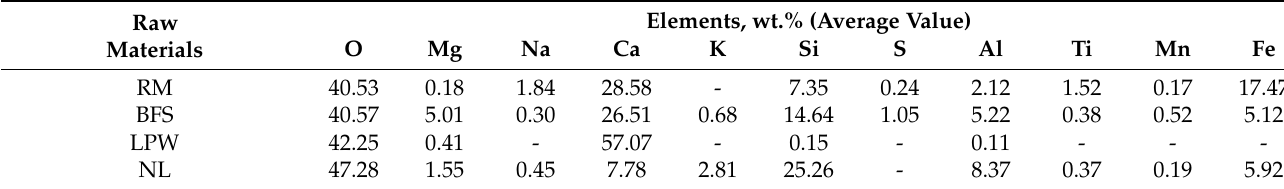
Table 2. Main elements of raw materials.